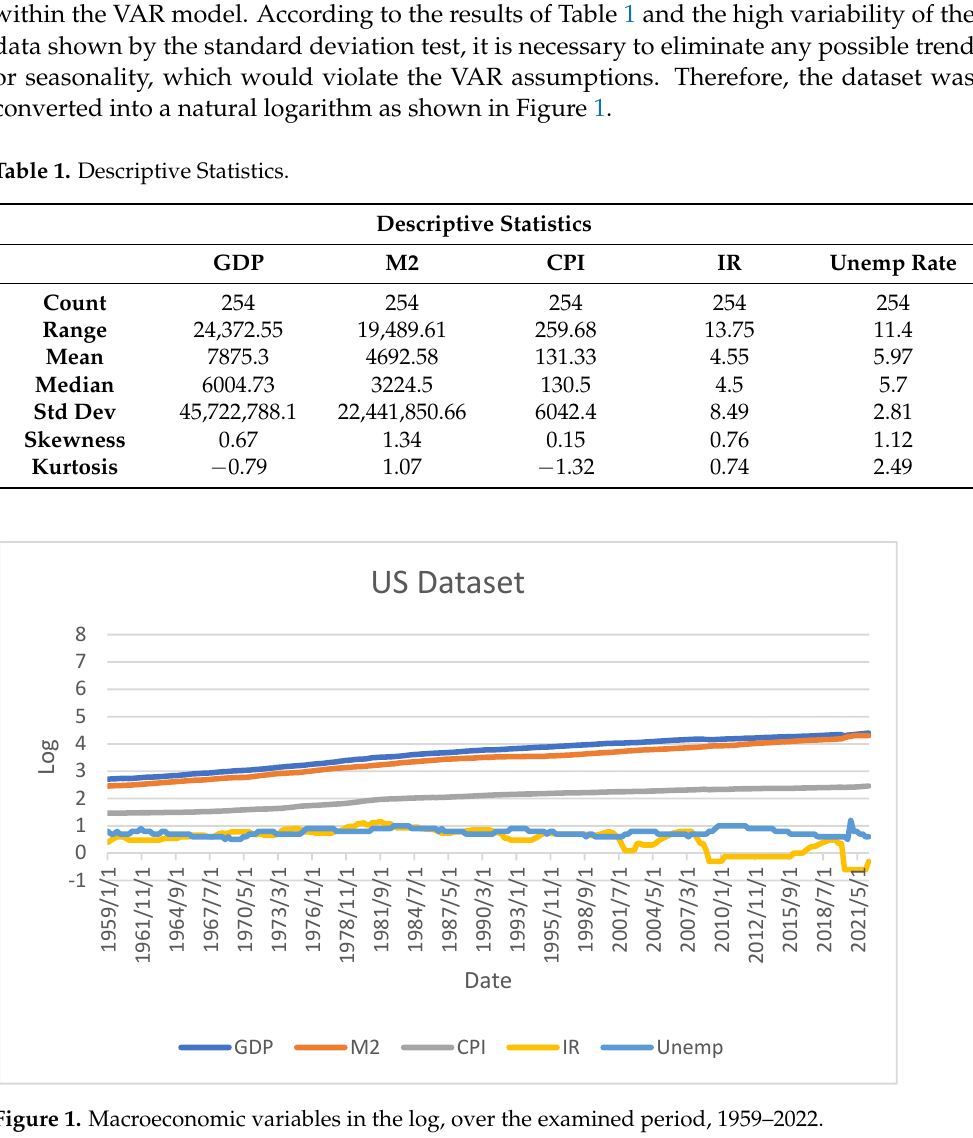
Table 2. Augmented Dickey-Fuller test.